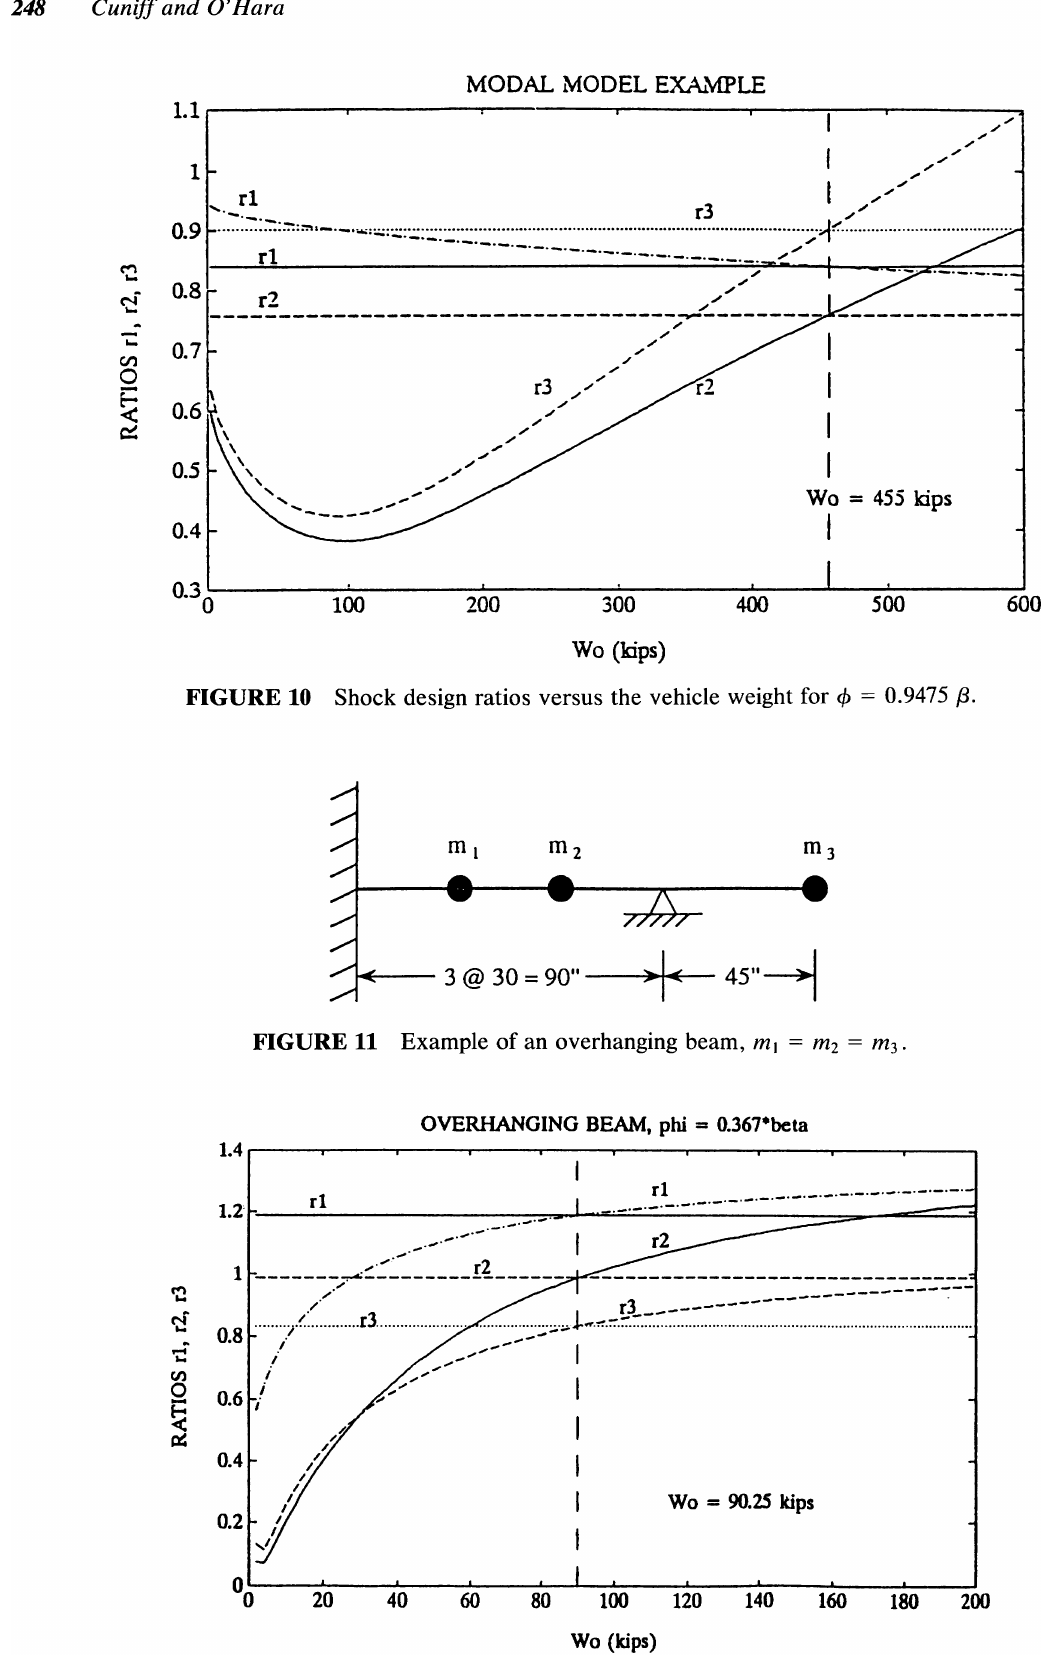
FIGURE 12 Shock design ratios versus the vehicle weight for cjJ = 0.367